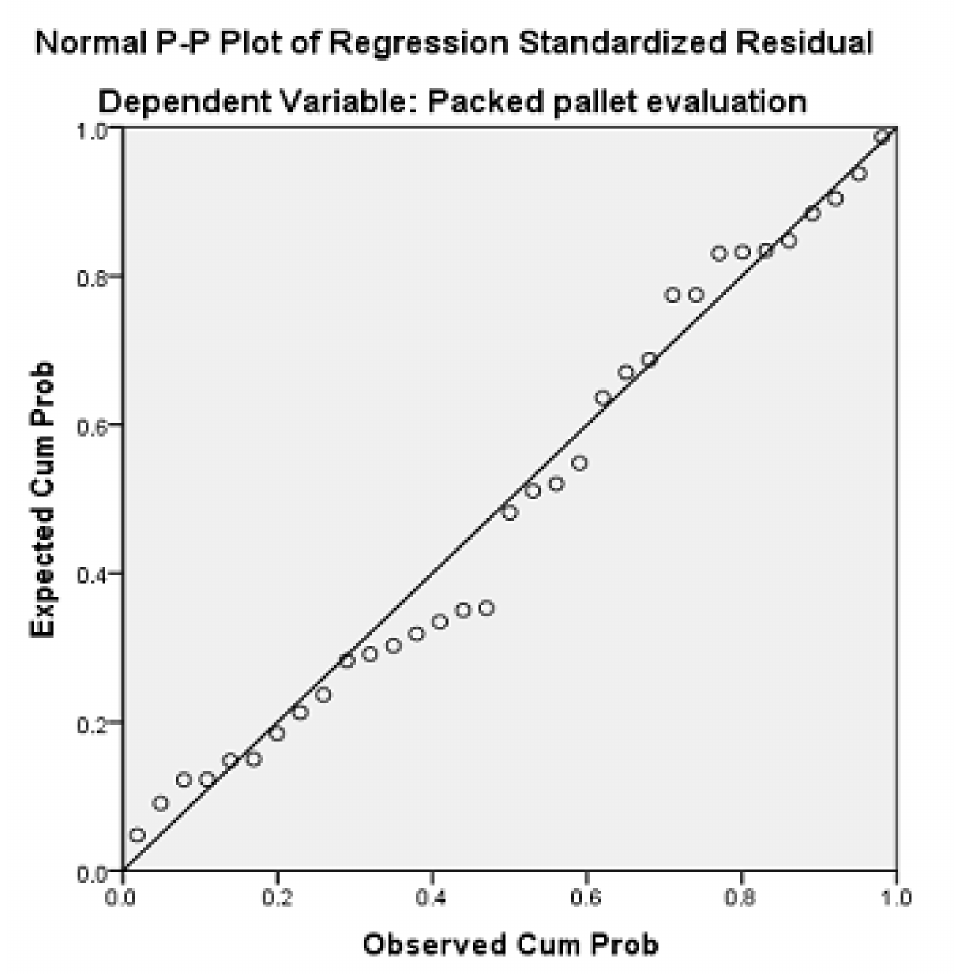
Figure 1. Predicted probability plot (for 2 principal